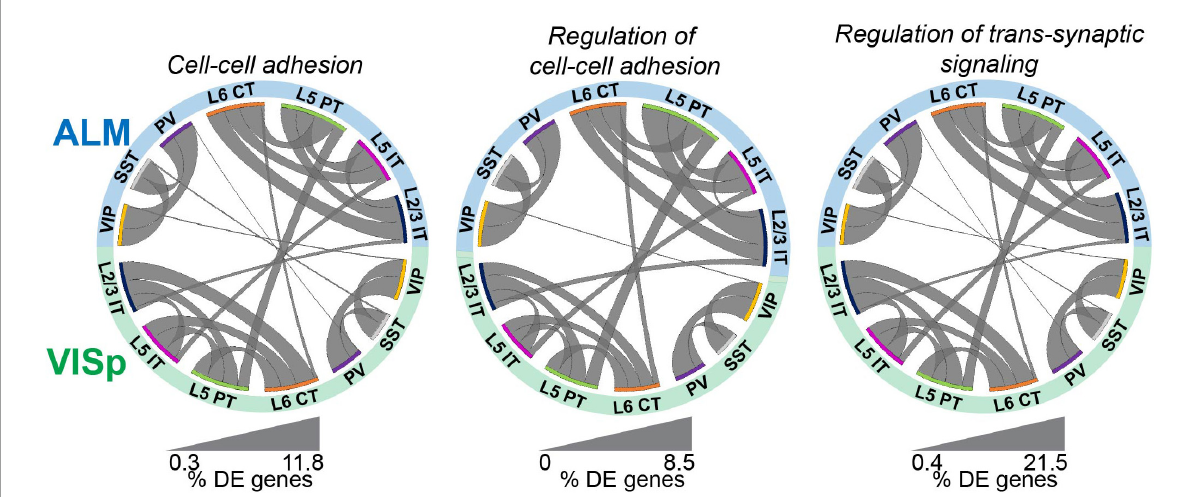
FIGURE3 Circuit-related genes are primarily differentiated by class rather than cortical region. Circos plot summary of the percentage of differentially expressed circuit-related genes found in each pairwise comparison. Circuit-related genes were identified using PANTHER gene ontology labels “cell-cell adhesion”, “regulation of cell-cell adhesion”, and “regulation of trans-synaptic signaling”. Classes are listed along the circumference of the plot in their respective brain region (blue - ALM; green - VISp). Bands connect classes that were compared in a pairwise differential expression test. Band thickness represents the proportion of differentially expressed genes in each test: thinner bands indicate a small percentage of distinguishing genes and thicker bands indicate a larger percentage of distinguishing genes. No genes involved in Regulation of cell-cell adhesion were differentially expressed between SST or PV cells across regions.